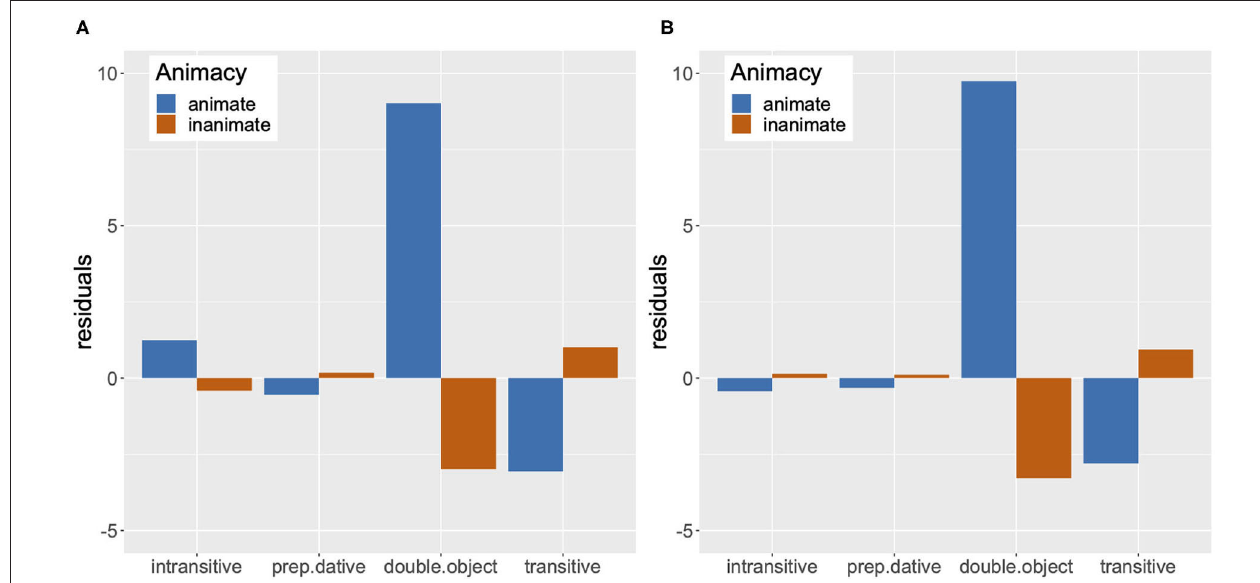
FIGURE 9 | Pearson residuals of each argument structure grouped by animacy for the expressions provided by participants in the single/double match condition, Experiment 3. (A) Double Match. (B) Single Match.